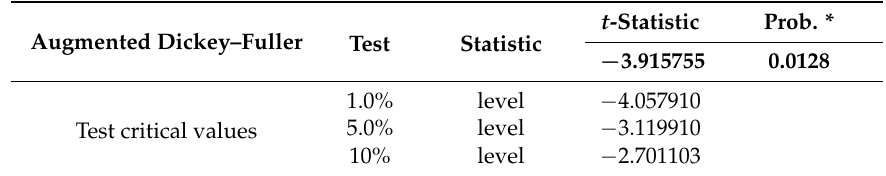
Table 4. Augmented Dickey–Fuller Unit Root Test on